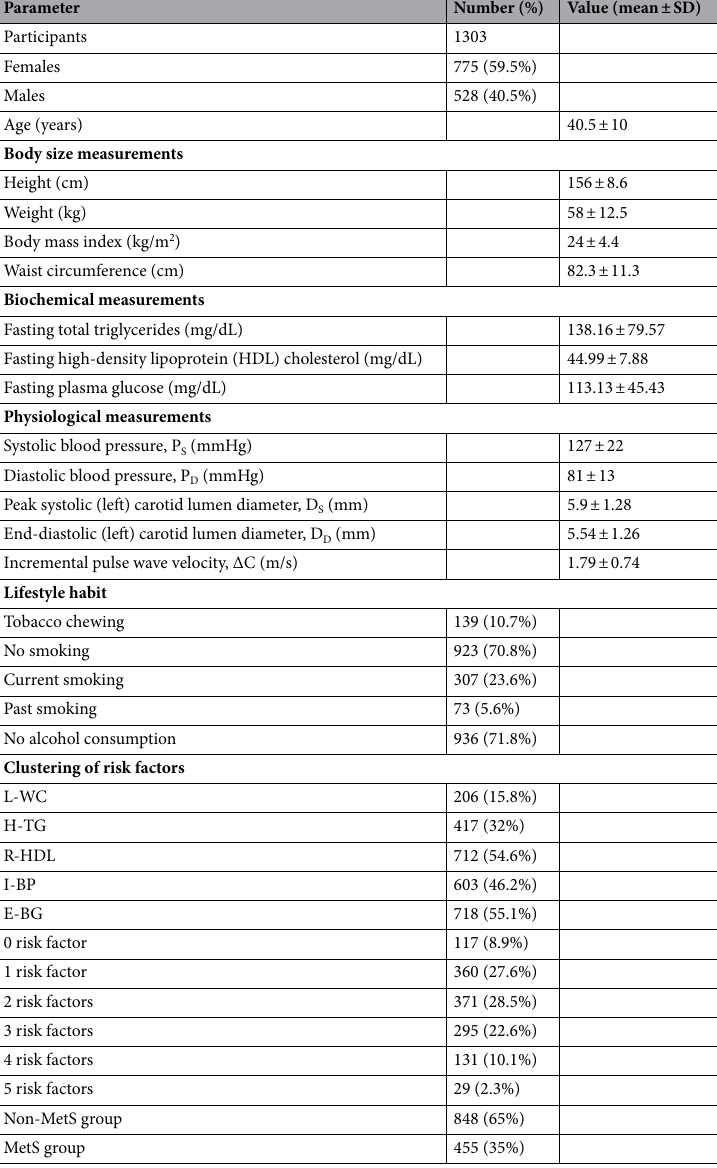
Table 1. Baseline demographics and characteristics of the study